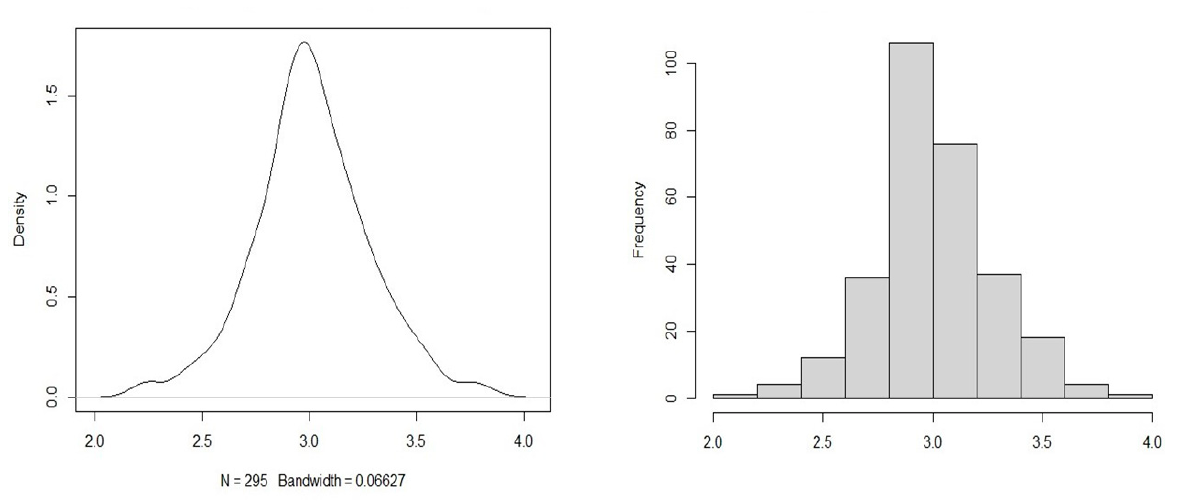
Figure 1. Spread of